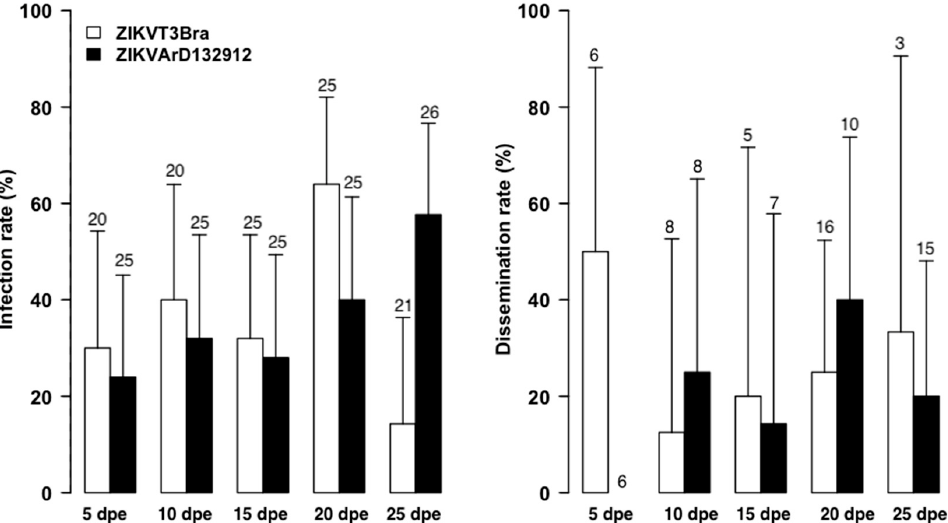
Figure 3. Infection and Dissemination Rates at 5, 10, 15, 20 and 25 dpe for A. aegypti from Senegal orally exposed to 10 5 PFU/mL for Brazilian ZIKV (ZIKVT3FBra) and 10 4 PFU/mL for Senegalese strains (ZIKV132912) frozen for a week at − 80 ◦ C. Values above each column mean the total number tested, nt = not